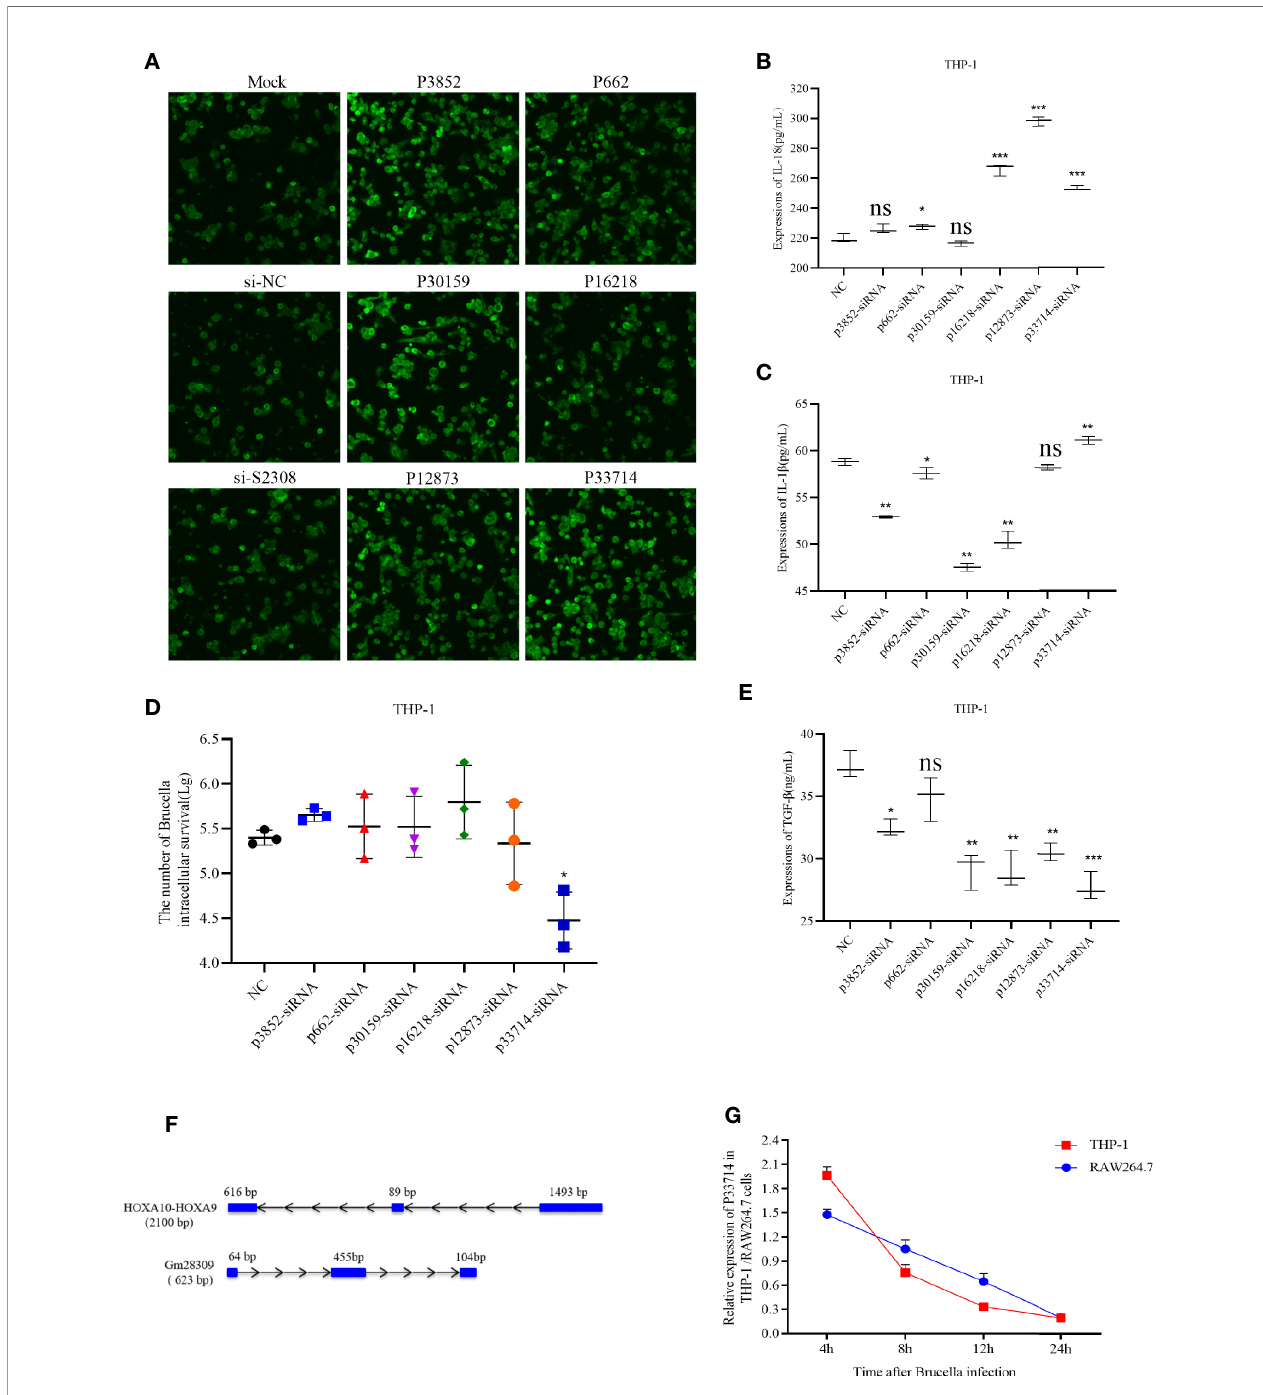
FIGURE 3 | Downregulation of lncRNA P33714 promotes secretion of pro-in fl ammatory interleukins in THP-1 cells infected by S2308. (A) The protein expression of NLRP3 in fl ammasome by immuno fl uorescent staining in THP-1 cells transfected with siRNAs of six candidate lncRNAs involved in in fl ammation. Bar, 450 µm. (B , C , E) Detection, using ELISA of IL-1 b , IL-18, and TGF- b secretion in the supernatant of THP-1 cells transfected with the indicated siRNA and infected with S2308 for 24 h. (D) The number of Brucella intracellular survivors in THP-1 cells transfected with siRNAs of six candidate lncRNAs involved in in fl ammation. (F) Gene structure of the HOXA10-HOXA9 (human) and Gm28309 (mice) transcripts. (G) Expression of Gm28309 and p33714 detected using qRT-PCR in THP-1 and RAW264.7 cells infected with S2308 at the indicated time point (4, 8, 12, and 24 h). Data are shown as mean ± SD (n = 3). *p < 0.05, **p < 0.01,***p < 0.001, one-tailed t-test. ns, not signi fi